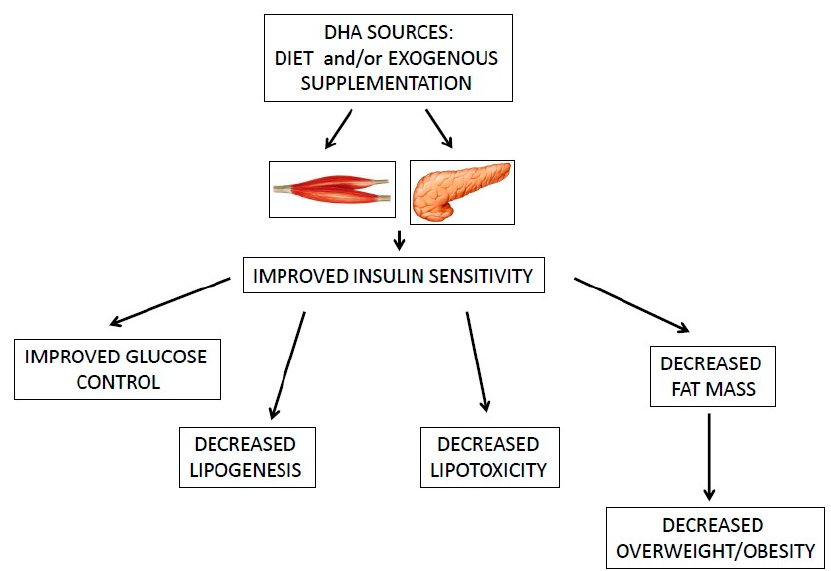
Figure 2. The role of DHA in insulin and glucose metabolism. DHA, docosahexaenoic acid.